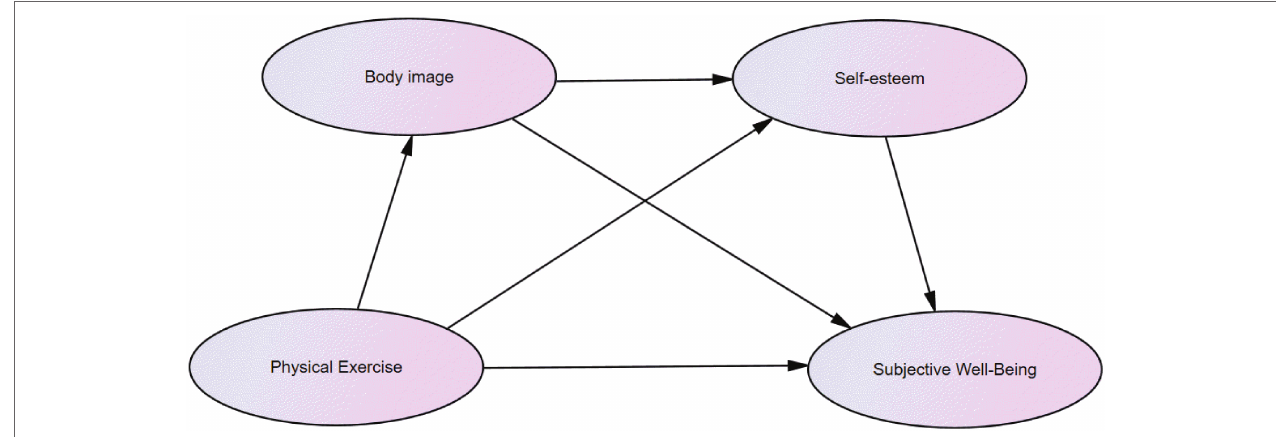
FIGURE 1 | Hypotheses model.